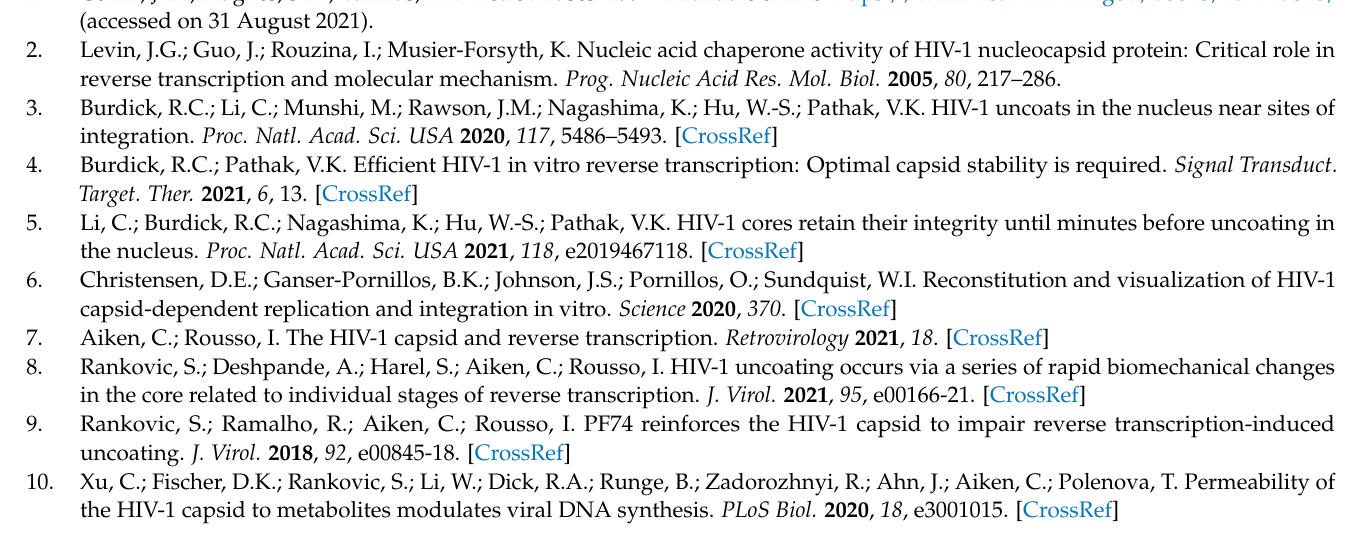
Figure S1: Fluorescent labeling of A54C NC protein, Figure S2: Fluorescence imaging control with unlabeled NC, Figure S3: DNA compaction as a function of rate of extension change, Figure S4: Variability of low NC concentration compaction, Figure S5: Step fitting of compaction